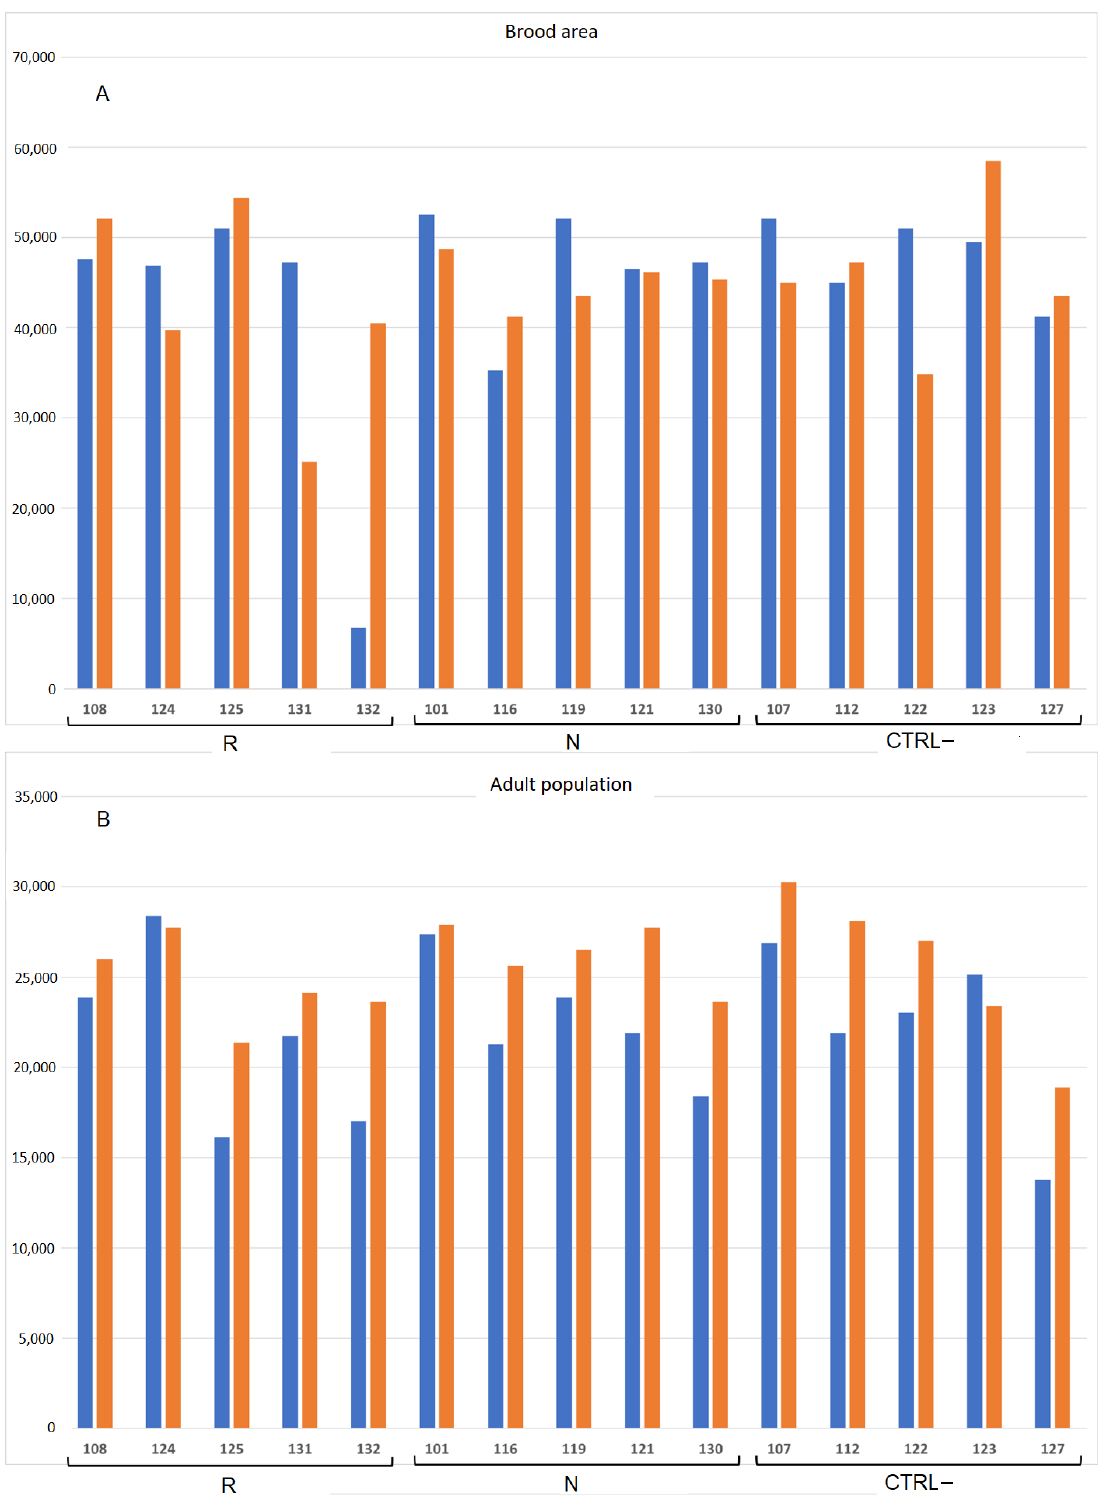
Figure 2. Number of brood cells ( A ) and adult bees ( B ) registered before (blue) and after treatment (orange) in the colonies (number ID) of the three groups (R: E. sativa , N: B. nigra , CTRL–: negative control). Before treatments, colony population was composed of 22,033.3 ± 1096.4 adult bees and 44,800.0 ± 2963.6 brood cells. The Kruskal–Wallis test showed no significant differ- ences between the experimental groups both for adult population (H(2, n = 15) = 0.196 p = 0.907) and brood area (H (2, n = 15) = 0.382, p = 0.826).